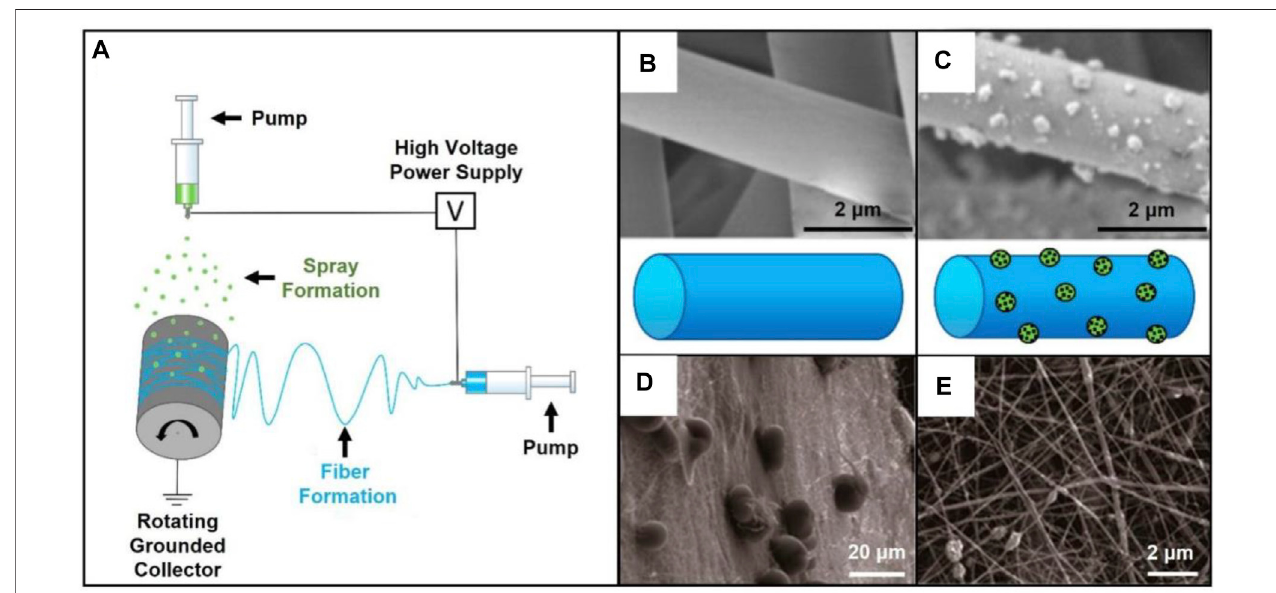
FIGURE 1 | (A) Electrospinning setup combined with electrospray. Reproduced with permission (Higuchi et al., 2019). Copyright 2019, MDPI. (B) SEM image of pristine PLA/PLGA fi bers. Reproduced with permission (Higuchi et al., 2019). Copyright 2019, MDPI. (C) SEM image of the fi bers covered by n-HA particles. Reproduced with permission (Higuchi et al., 2019). Copyright 2019, MDPI. (D) Typical SEM image of the AMPs-loaded PLGA microspheres deposited on the barrier layerofgelatin/chitosan fi bers.Reproducedwithpermission(Heetal.,2018).Copyright2018,MDPI. (E) SEMimageshowingtheosteogeniclayermadeofgelatin/ chitosan fi bers containing n-HA. Reproduced with permission (He et al., 2018). Copyright 2018, MDPI.